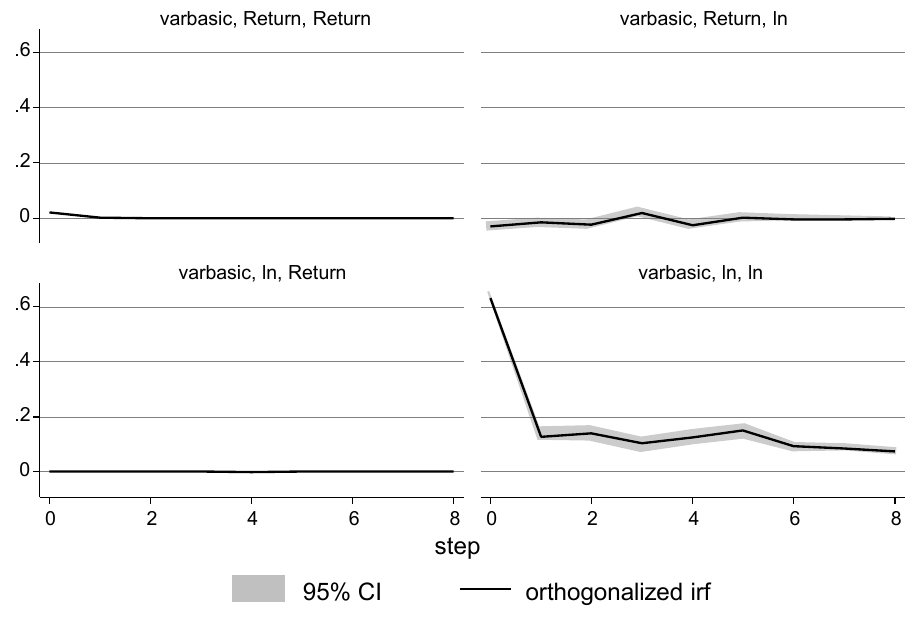
Figure 4. Orthogonalized impulse-response function (VAR with 5